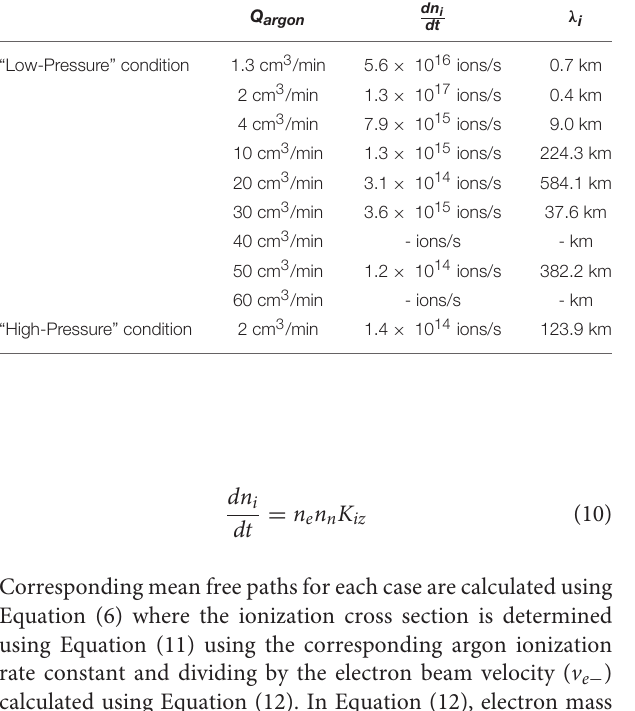
TABLE 3 | Ion production rates and mean free paths for the “Low-Pressure” and the “High-Pressure” conditions. Q argon dn i dt λ